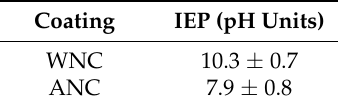
Table 5. Isoelectric points (IEP, in pH units) of the two nanocomposites applied on glass slides.